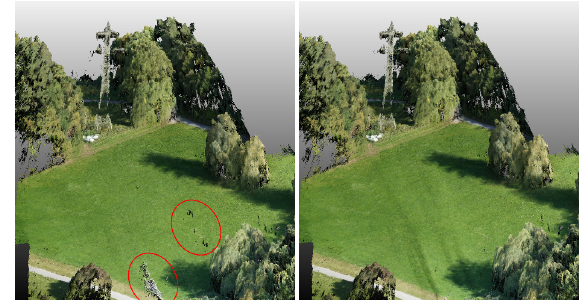
Figure 13. Comparison of 3D reconstruction methods. The left image shows a semi dense point cloud created using PMVS. It is Figure 15. Comparison of 3D reconstruction: The left image clearly visible that the local region growing approach does not shows the reconstruction without filtering the power lines and give good results for vegetation. On the right our dense 3D the right image the reconstruction with filtered power lines. It is reconstruction pipeline provides detailed reconstruction for clearly visible that filtering the power lines removes vegetation and thus enables further inspection tasks. Note that reconstruction artifacts like spikes toward the power line the power lines are not reconstructed due to the semantic (marked by red ellipses). filtering of the depth maps.